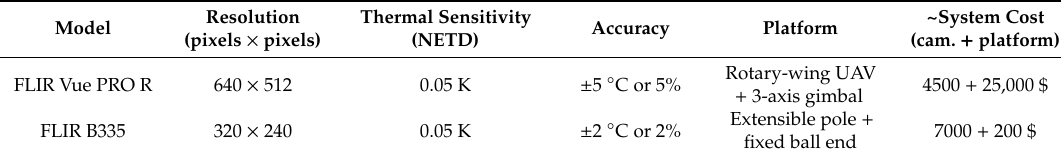
Figure 3. Lifting platforms for the thermal cameras: ( a ) Drone Quasar unmanned aerial vehicle (UAV) and ( b ) telescopic pole. Table 2. Thermal cameras and platforms used in the study.